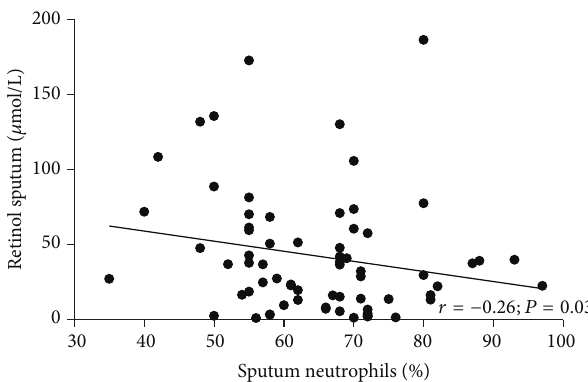
Figure 1: Correlation between retinol sputum and sputum neu- trophil concentrations.